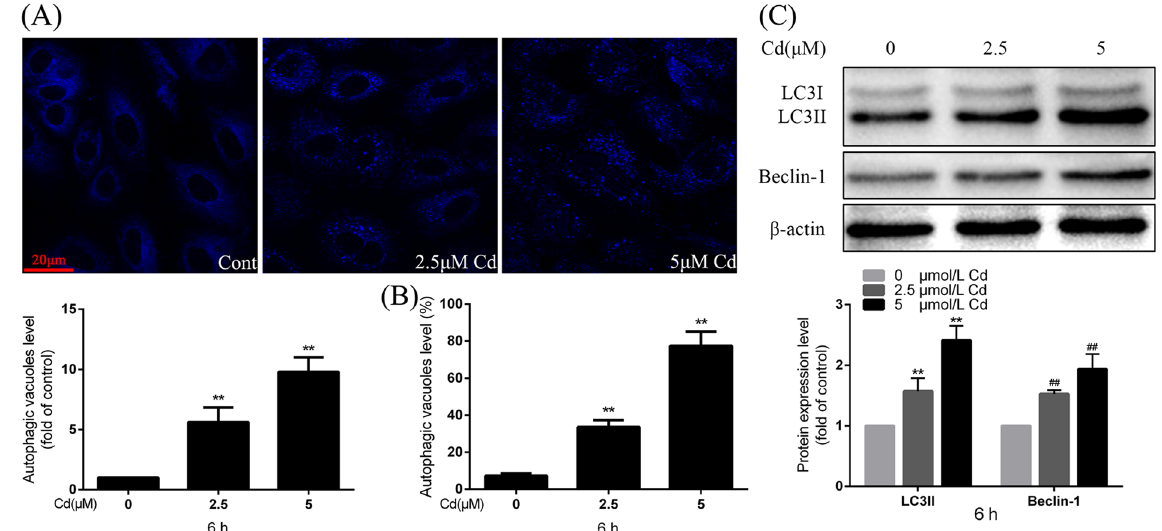
Figure 3. Effects of Cd treatment on activation of autophagy in rPT cells. (A) rPT cells were incubated with 0, 2.5, and 5 μ M Cd for 6 h and autophagic vacuoles were analyzed by confocal microscopy after MDC staining. Fluorescence particles in the cytoplasm indicate autophagic vacuoles. The quantified analyses as assessed by MDC staining are expressed as mean ± SEM of three separate experiments; each experiment was performed in triplicate (n = 9). (B) rPT Cells were treated with Cd for 6 h and autophagy was assessed using flow cytometry. Data are mean ± SEM of three separate experiments, each experiment performed in triplicate (n = 9). (C) LC3II and Beclin-1 protein levels were assessed by western blot analysis after Cd treatment for 6 h. The quantitative analysis was performed on western blot images of four independent experiments (mean ± SEM, n = 4). ** P < 0.01 and ## P < 0.01.